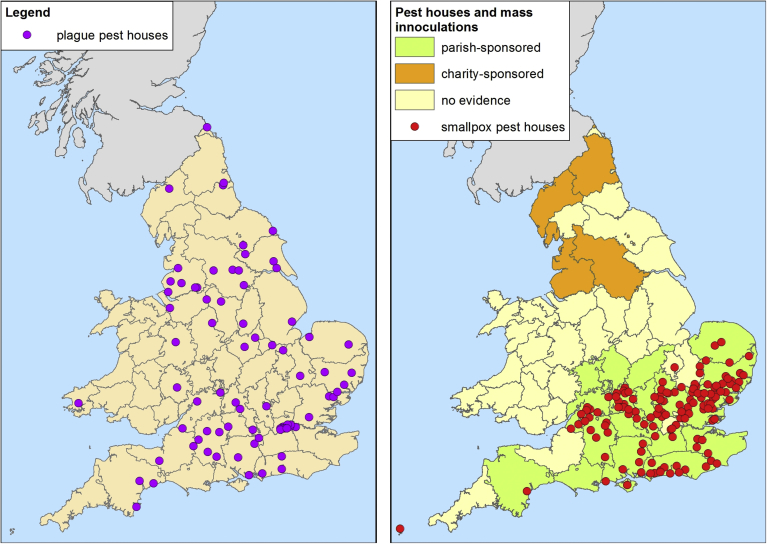
The geographical distribution of pest houses associated with plague (c.1560–1666) (a), and mass inoculations and pest houses, 1700–1799 (b). Sources: British History Online (including Victoria County Histories); Brunton, 1990, appendix VII; Crook (2006); Currie (2005); Dobson (1997); National Archives online catalogue; Smith, 1987; Shrewsbury, 1971; www.workhouses.org.uk.